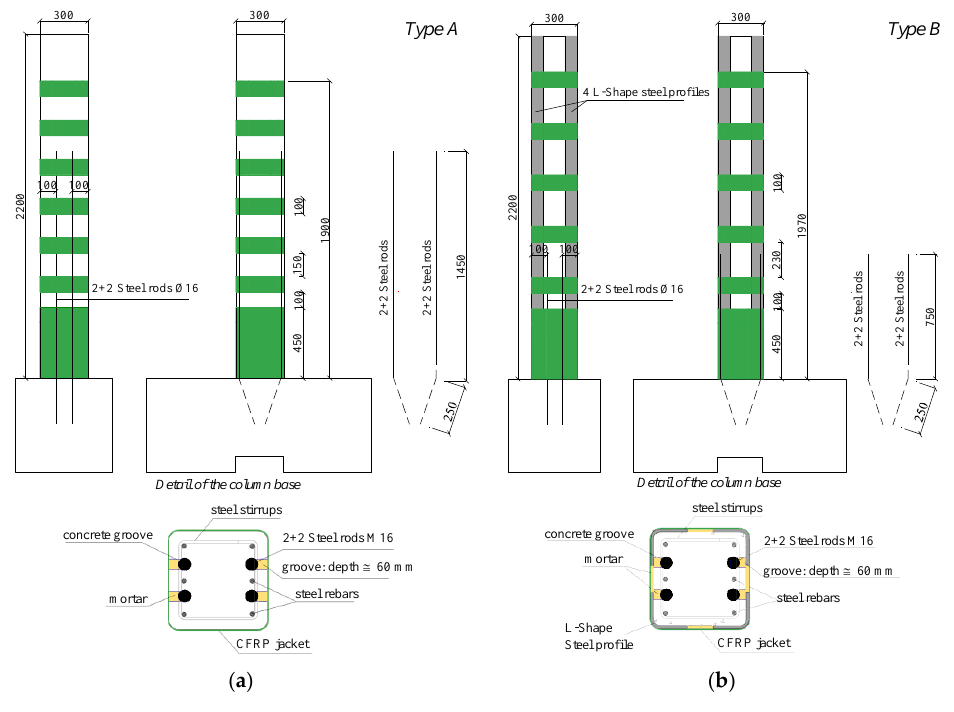
Figure 2. Strengthening layouts: “type A” ( a ); “type B” ( b